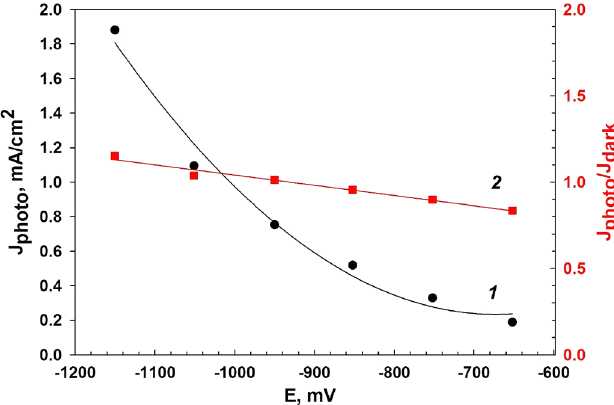
Fig. 6. The dependence of photocurrent density on external voltage for CZTS fi lms with Cu/(Zn+Sn) =0.5: (1) photocurrent decay; (2) (cid:1) normalization at J dark (solid-line curves are approximations by second order and fi rst order polynomials,